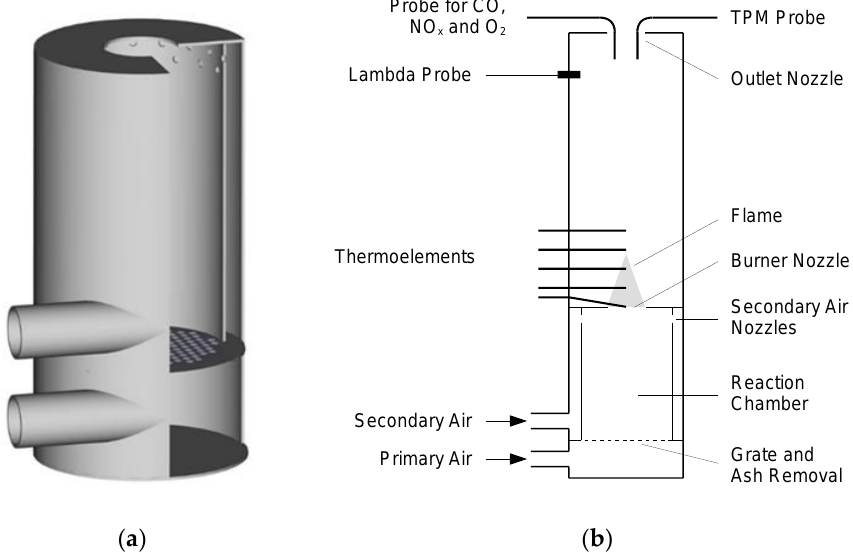
Figure 1. Schematic model of the burner ( a ) 3-D scheme without flanges and flue gas measuring section ( b ) 2-D scheme of the experimental set-up.